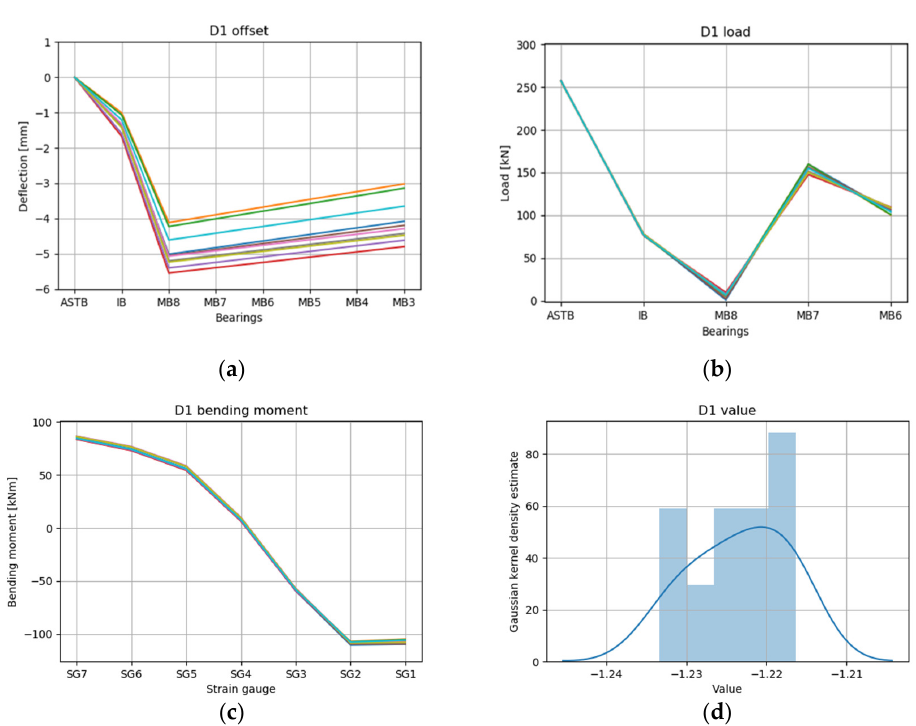
Figure 17. RL results for draft condition D1 top 10 cases: ( a ) offset, ( b ) load, ( c ) bending moment, and ( d ) value.